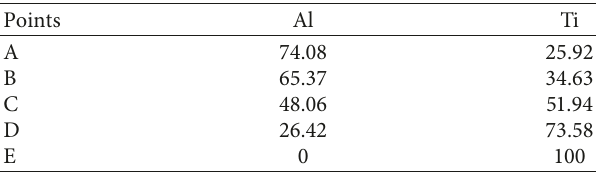
Table 5: The chemical composition (at.%) in different points, as marked in Figure